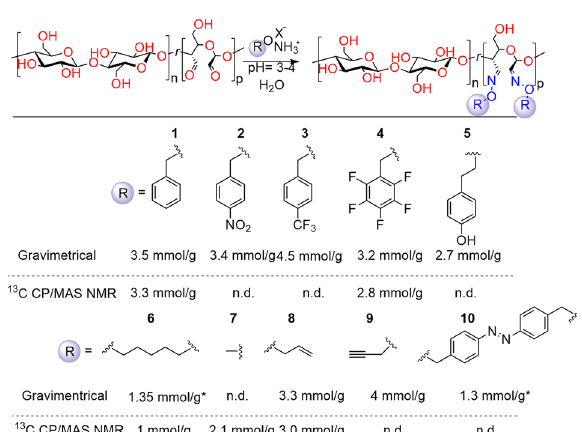
Fig. 3 | Scopeof O -substituted hydroxylamines. Reaction conditions: ca. 150mg of DA-CNF (drybasis),0.12M solutionof RONH 3 + X − (~1.5 equiv.), 10mLH 2 O, room temperature, overnight; X=Cl or OTf. Reaction is performed on DA-CNF with 4.8mmol/gofaldehydegroups.*ThereactionsareperformedonDA-CNF fi